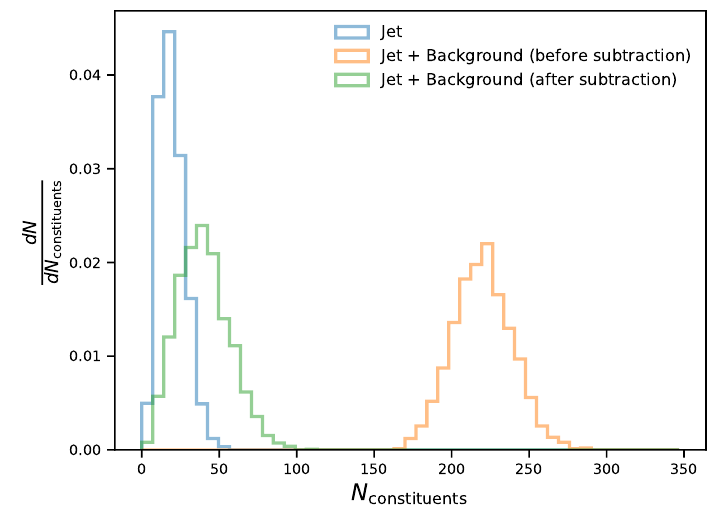
Figure 10 . Distributions of particle multiplicities in the training jet